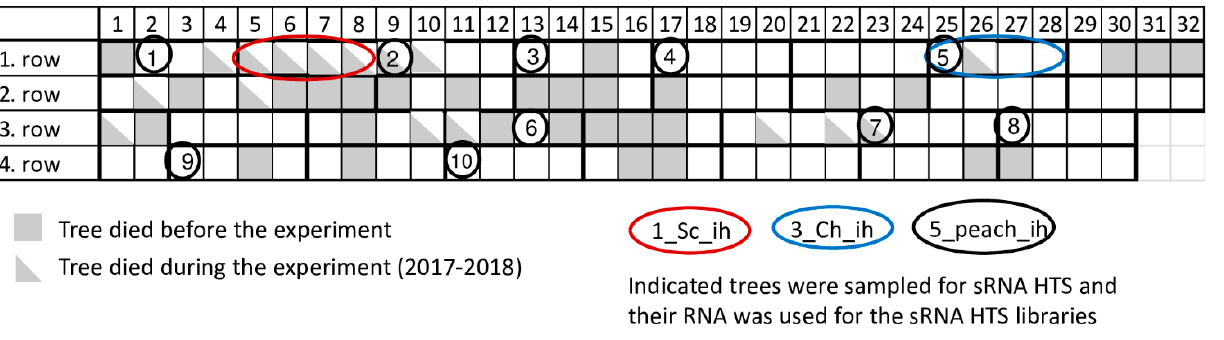
Figure 1. Schematic representation of the isolator, where investigated peach trees were grown.